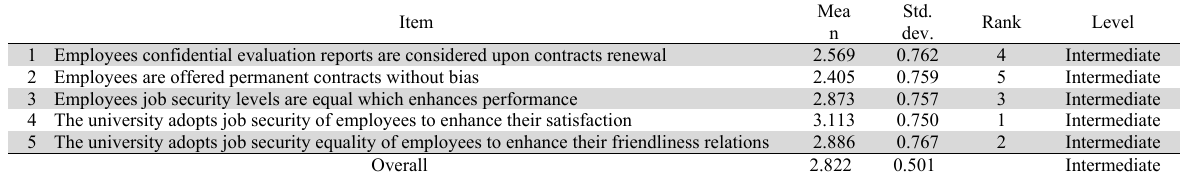
The mean and standard deviation of the factors associated with job security